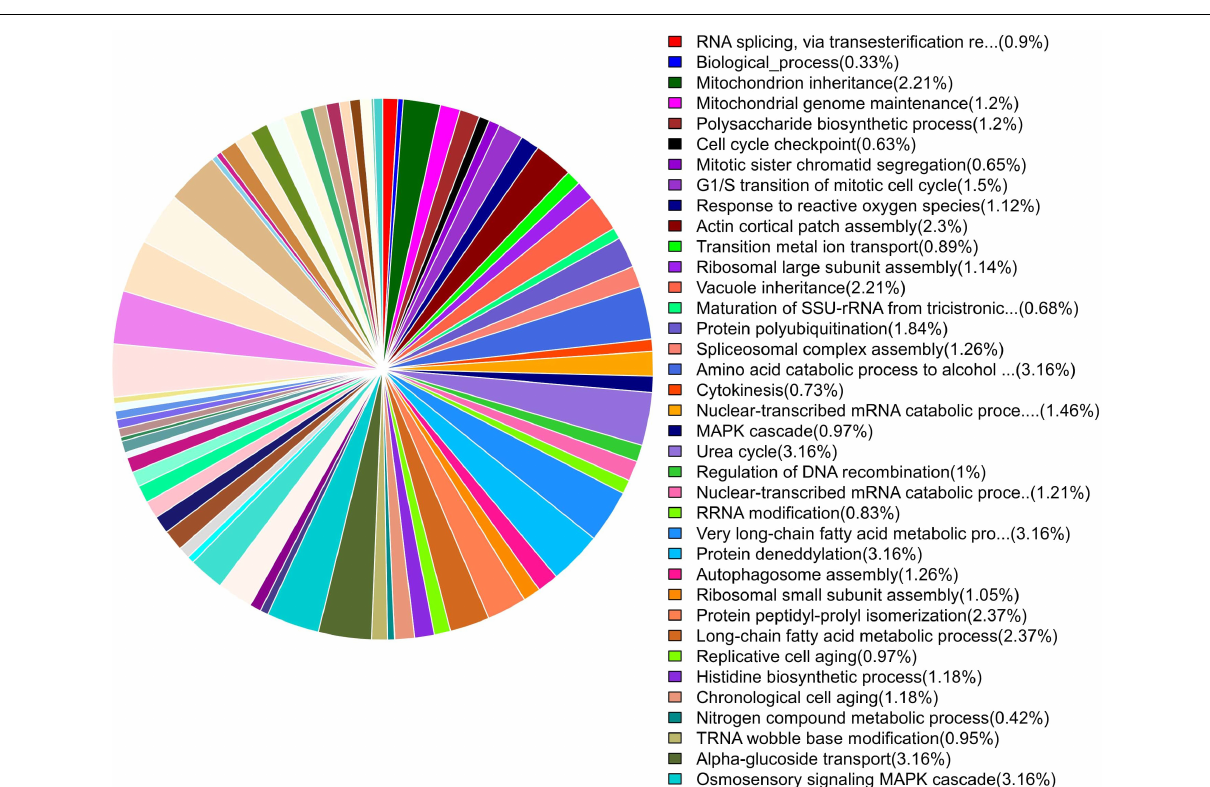
Frontiers in Microbiology |